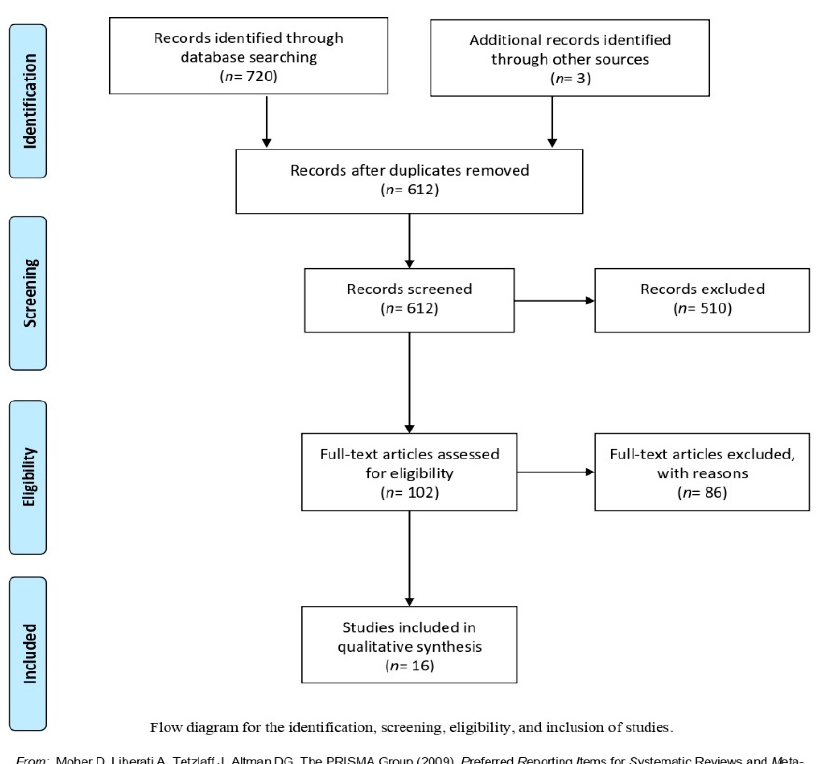
Figure 1. PRISMA Flow Diagram.